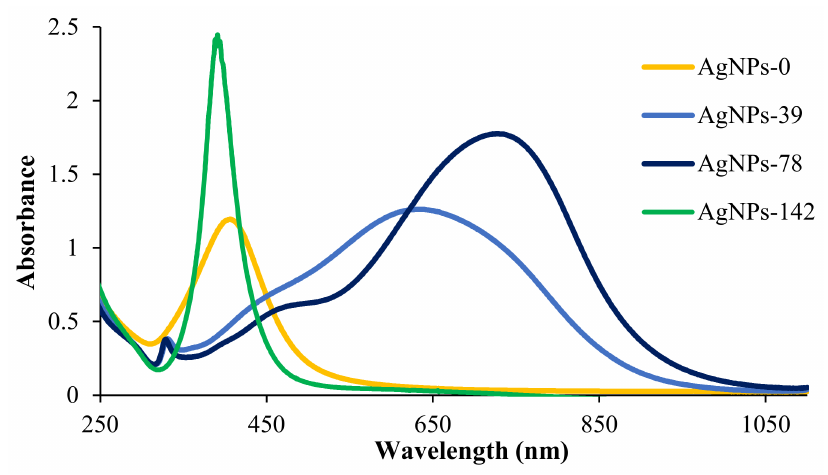
Figure 1. UV-Vis spectra of AgNPs-0, AgNPs-39, AgNPs-78 and